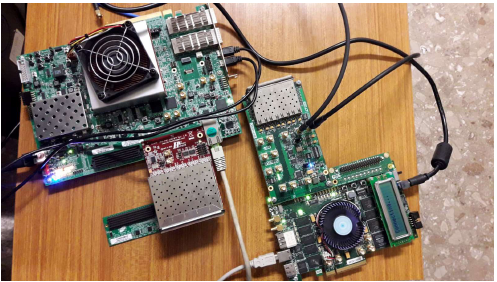
the Altera Stratix-IV Development board with an HSMC Terasic daughter card emulating the detectors data